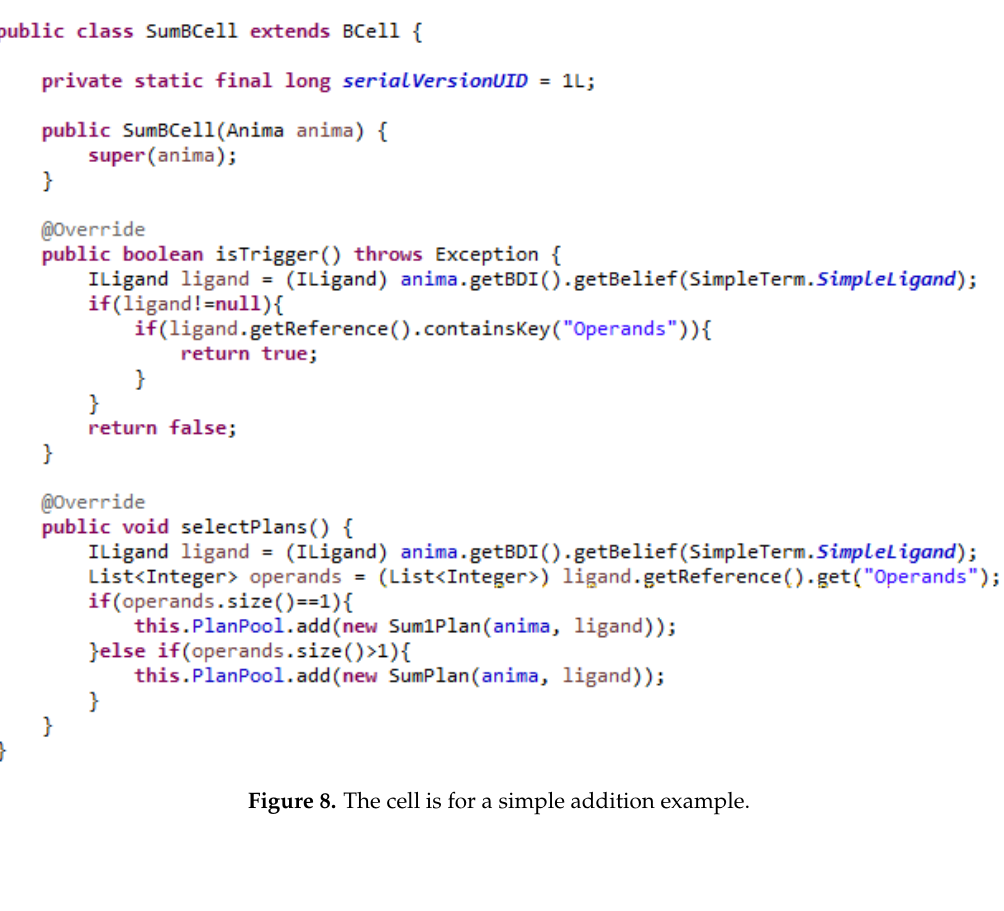
Figure 8. The cell is for a simple addition example.